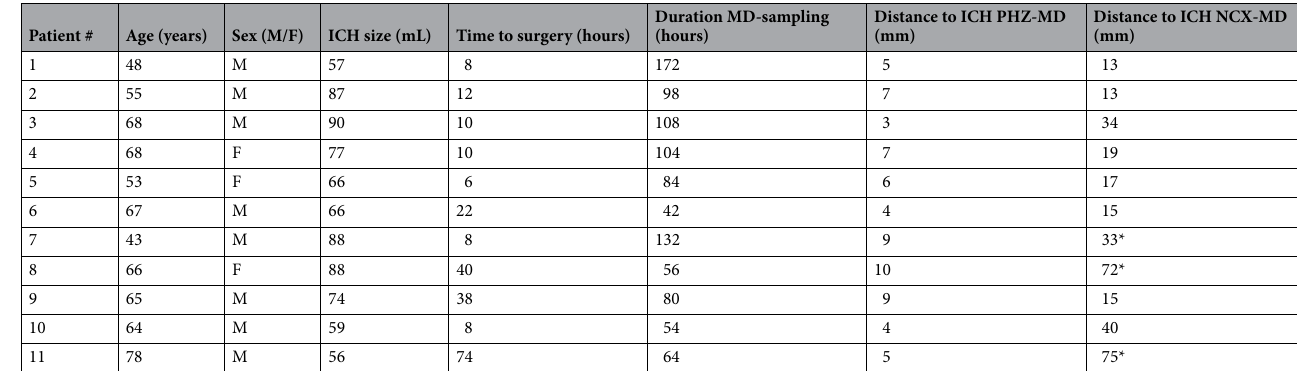
Table 1. Patient characteristics. M male, F female, ICH intracerebral haemorrhage, MD microdialysis, PHZ perihemorrhagic zone, NCX non-injured cortex. * Contralateral to